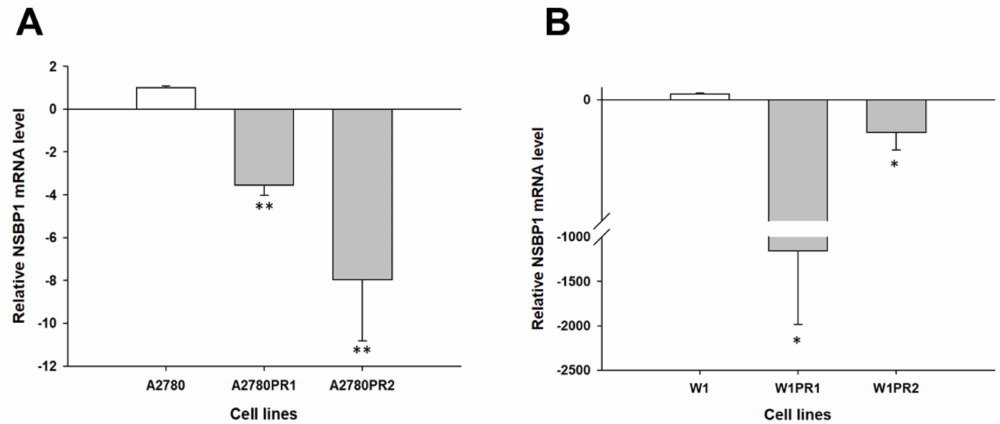
Figure 2. Expression analysis (Q-PCR) of the NSBP1 gene in the A2780 ( A ) and W1 ( B ) PAC-resistant cell lines. The figure presents the relative gene expression in the resistant cell lines (grey bars) with respect to that in the sensitive cell line (white bars), which was assigned a value of 1. The values were considered significant at * p < 0.05 and ** p < 0.01.